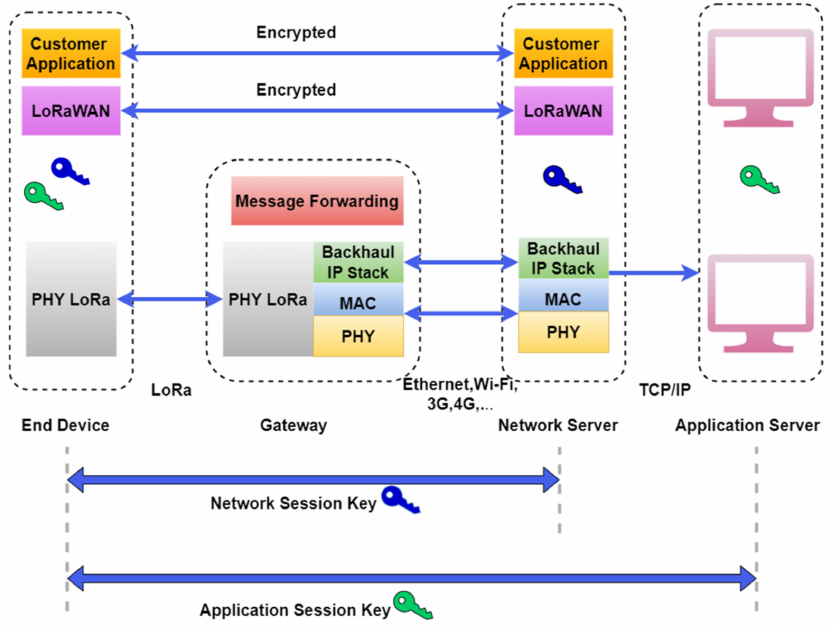
Figure 1. LoRaWAN protocol